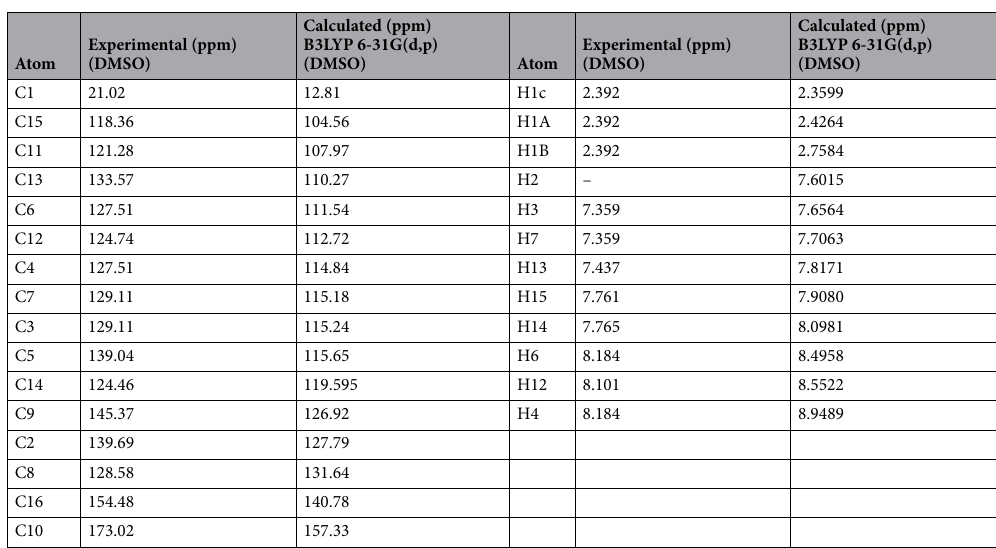
Table 4. Theoretical and experimental 1H and13C isotropic chemical shifts (with respect to TMS, all values in ppm) for compound 12 .